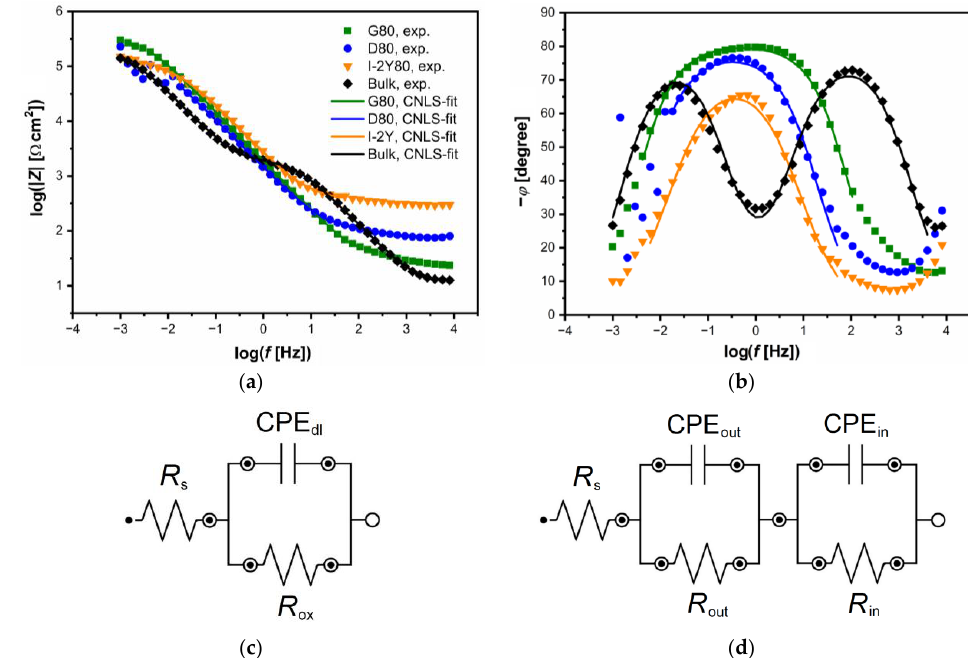
Figure 10. Bode diagrams for the CpTi G2 cellular lattice with TPMS architecture of G80, D80, I-2Y80, and the bulk electrode in 0.1 M KOH solution saturated with O 2 at 25 °C with the equivalent electrical circuit models used for CNLS-fitting: ( a ) Magnitude; ( b ) Phase angle; ( c ) One-CPE model; ( d ) Two-CPE model. Experimental data (symbols) and continuous lines (CNLS fit).